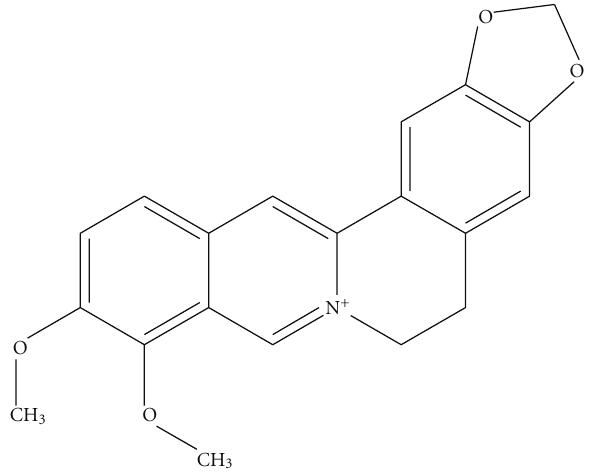
Figure 1: Chemical structure of